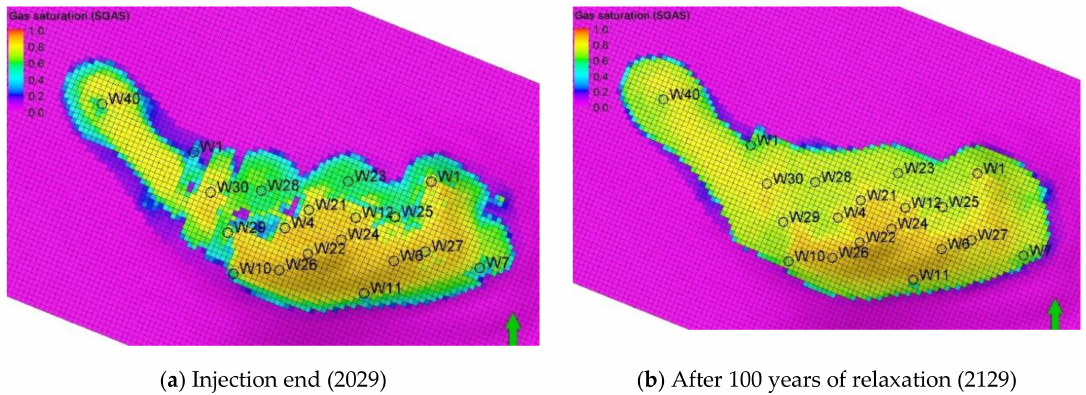
Figure 45. Distribution of gas saturation at the structure